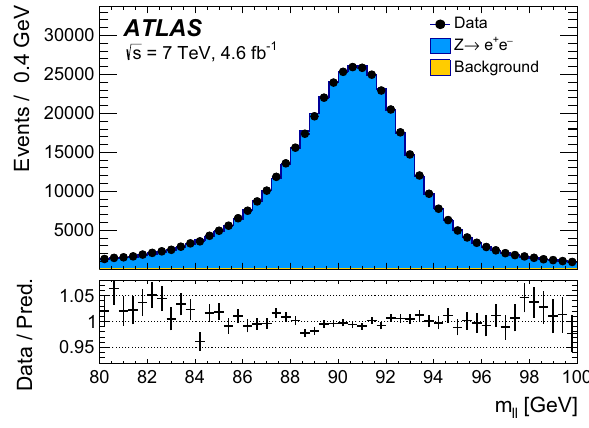
Fig. 9 Dielectron invariant mass distribution in Z → ee events. The data are compared to the simulation including signal and backgrounds. Correctionsforenergyresolution,andforreconstruction,identification, isolation and trigger efficiencies are applied to the simulation; energy- scale corrections are applied to the data. Background events contribute less than 0.2% of the observed distribution. The lower panel shows the data-to-prediction ratio, with the error bars showing the statistical